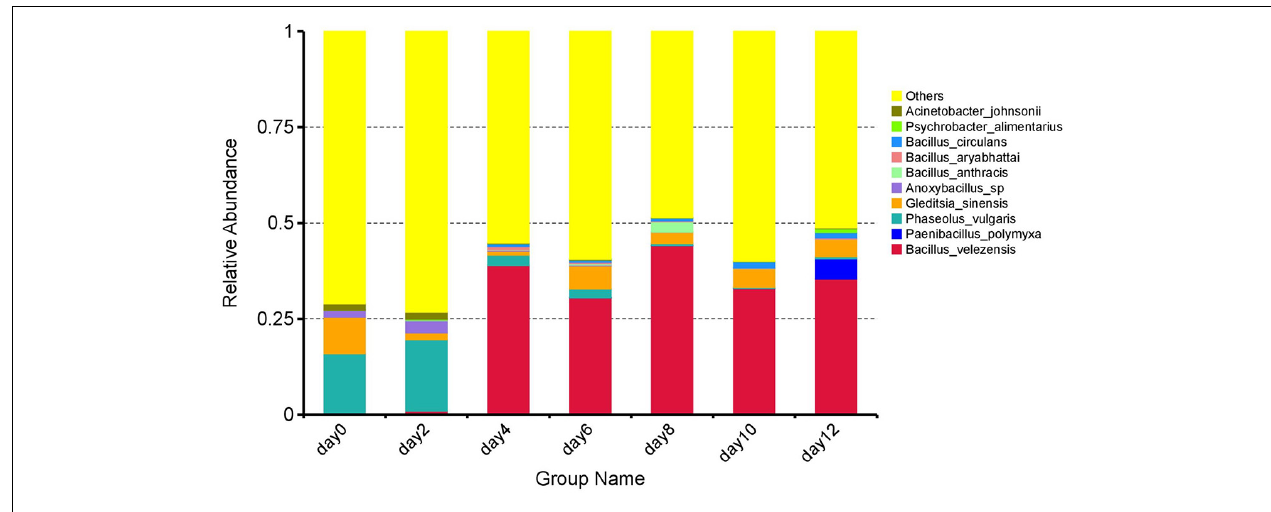
FIGURE 3 | The relative abundance of bacterial species (top 10) at different stages of storage.